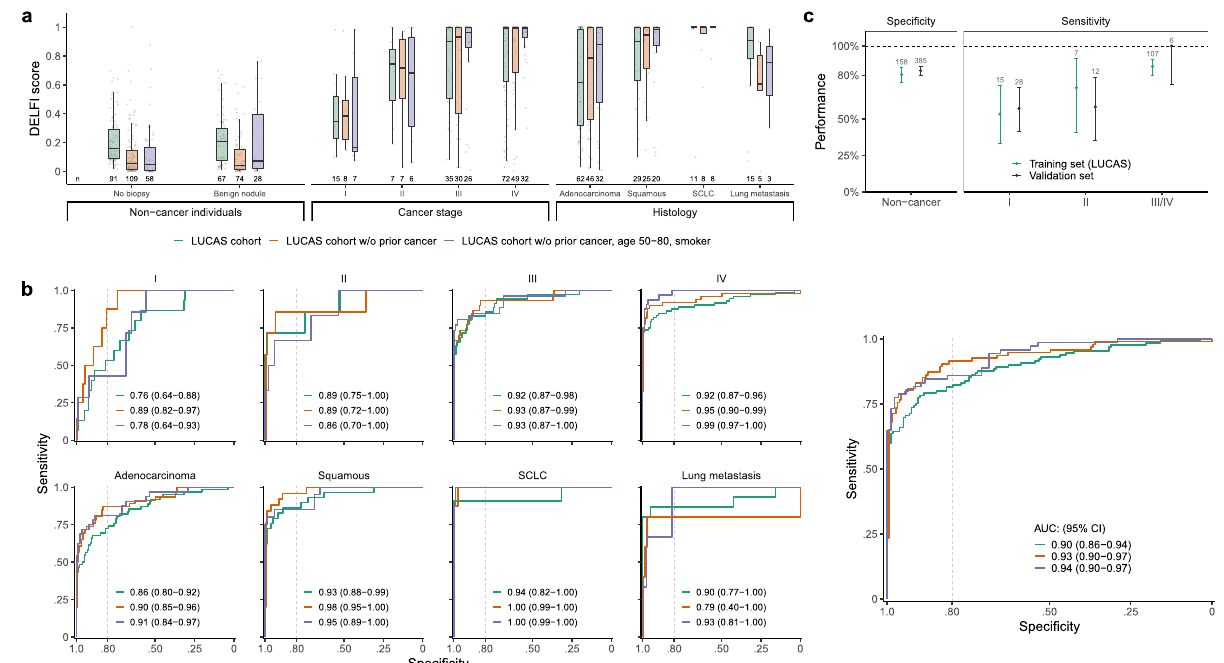
Fig. 3 Performance of DELFI analyses for lung cancer patients and non-cancer individuals. a DELFI score distribution across non-cancer individuals and cancer patients, strati fi ed by stage and histology groups in the LUCAS cohort. The box-plot shows the median DELFI score and the inter-quartile range with the individual sample values overlaid as dots. The non-cancer cases with or without benign lesions have a lower DELFI score compared to cancer cases and there is a stepwise increase in DELFI score by stage. The highest median DELFI score is observed in SCLC cases. Green curves indicate all individuals in the LUCAS cohort, orange represents patients without prior history of cancer, and blue indicates patients without prior history of cancer, age 50 – 80, and with ≥ 20 pack-year smoking history. The center line in the boxplots represents the median, the upper limit of the boxplots represents the third quantile (75th percentile), the lower limit of the boxplots represents the fi rst quantile (25th percentile), the upper whiskers is the maximum value of the data that is within 1.5 times the interquartile range over the 75th percentile, and the lower whisker is the minimum value of the data that is within 1.5 times the interquartile range under the 25th percentile. b ROC analyses of the overall LUCAS cohort as well as by stage and histology. The dotted vertical line in the ROC fi gures represents an 80% speci fi city as a decision boundary. c Analysis of a DELFI fi xed model and score cutoff of 0.344 determined from the LUCAS cohort was applied in the validation cohort. The performance of this classi fi er in the independent cohort was similar to LUCAS in both speci fi city (left) and sensitivity (right) across all tumor stages. The number of samples in the training and validation sets are indicated in the labels of the horizontal axis. The intervals presented re fl ect a 90% con fi dence interval. Additional analyses at other speci fi cities are indicated in Supplementary Fig.